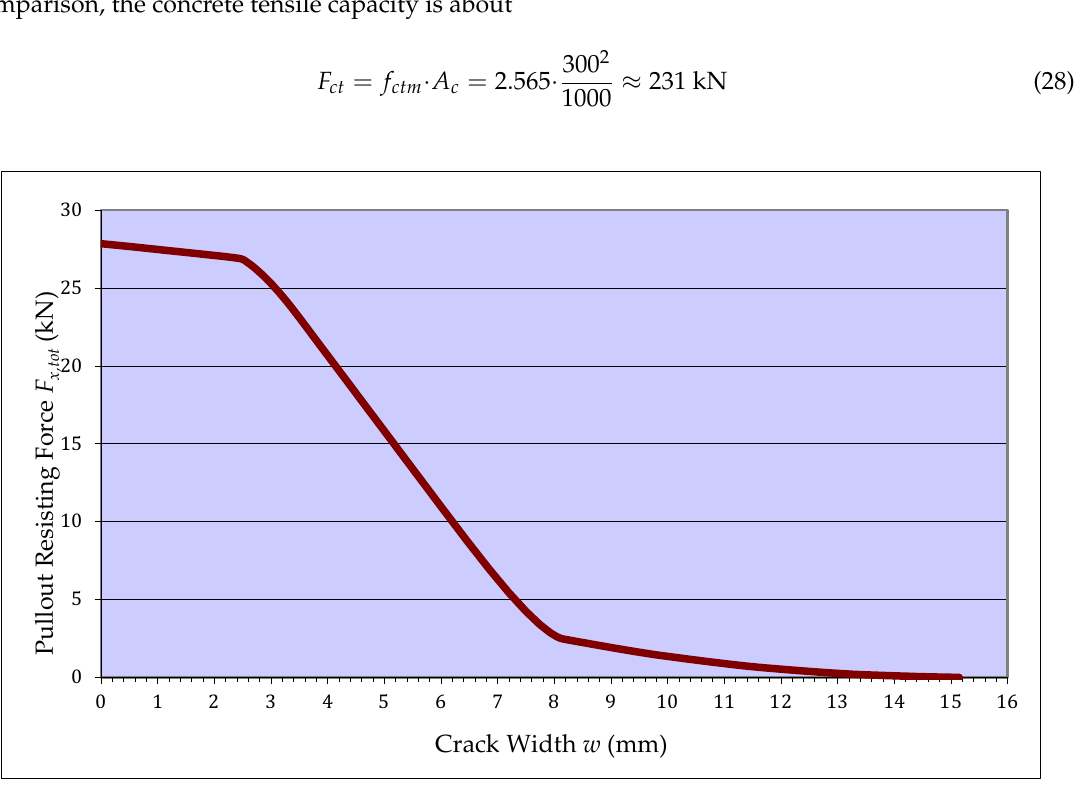
Figure 9. Overall pullout resistance of 300/300 mm section C25/30, ρ = 0.5%.